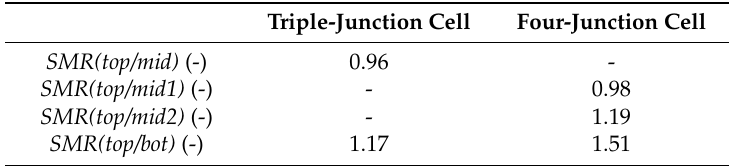
Table 4 . SMR values for both cases (with TJSC and FJSC) under normal incidence of the light. Triple-Junction Cell